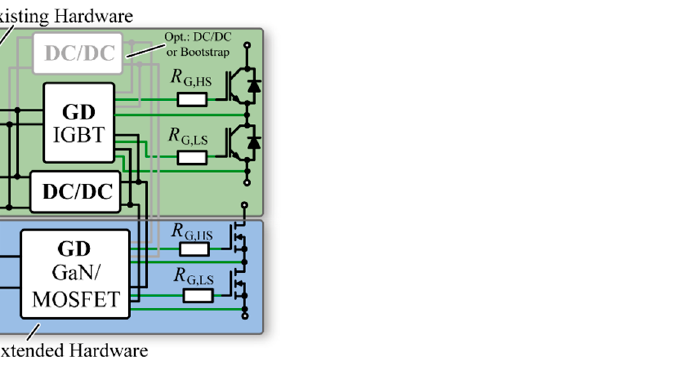
Figure 4. Auxiliary circuits for driving existing IGBTs (DC/DC converter(s), bootstrap, gate driver,…) and reutilization for light-load operating SiC/GaN extension.